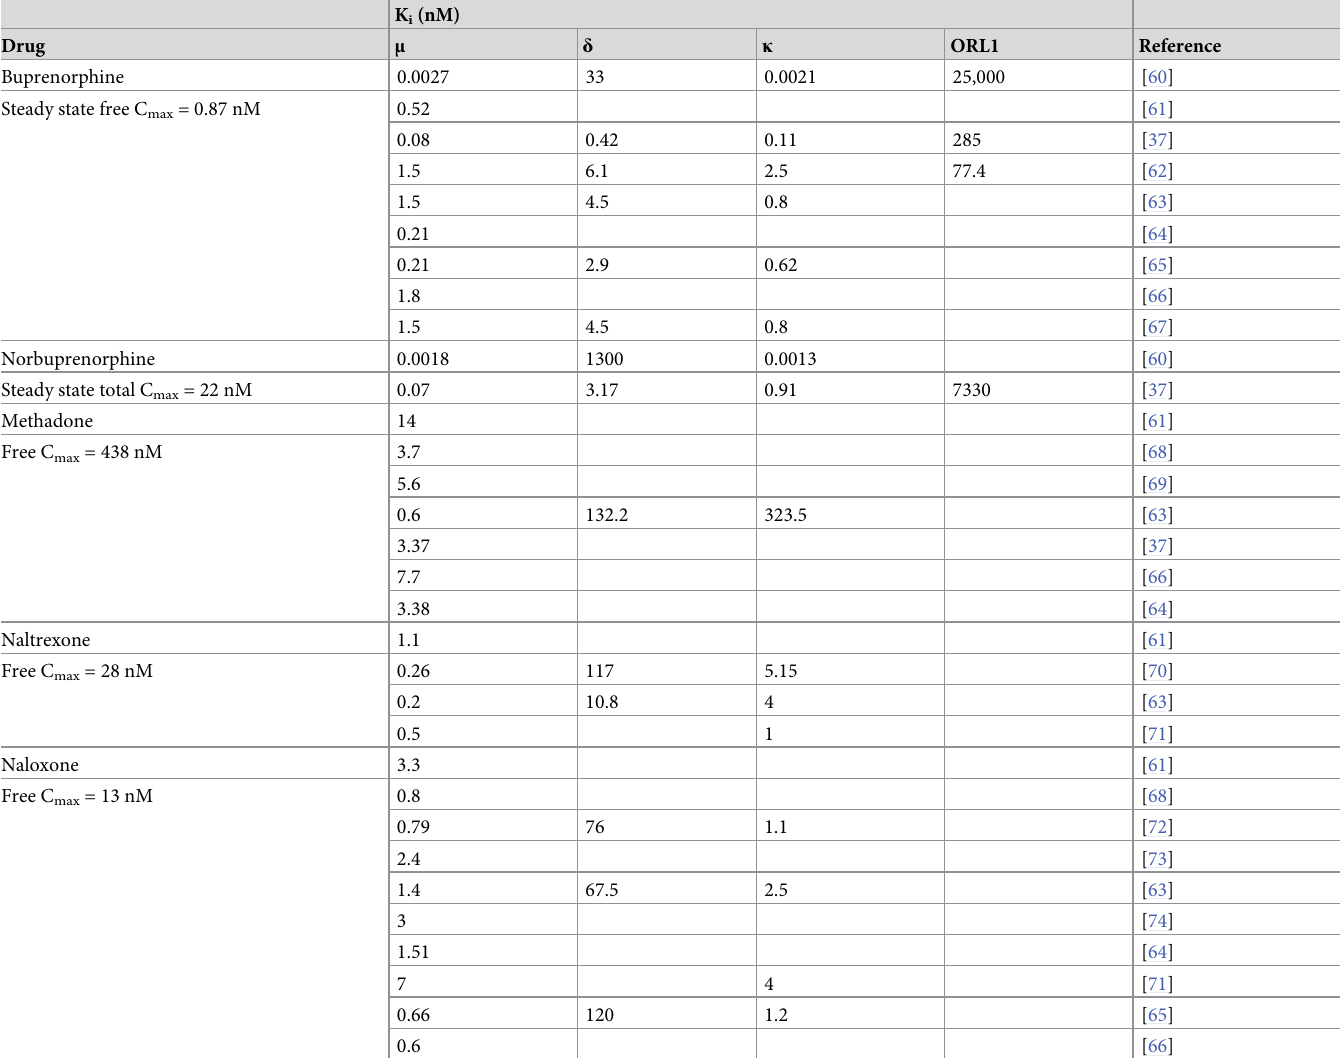
Table 2. Binding affinity at human opioid